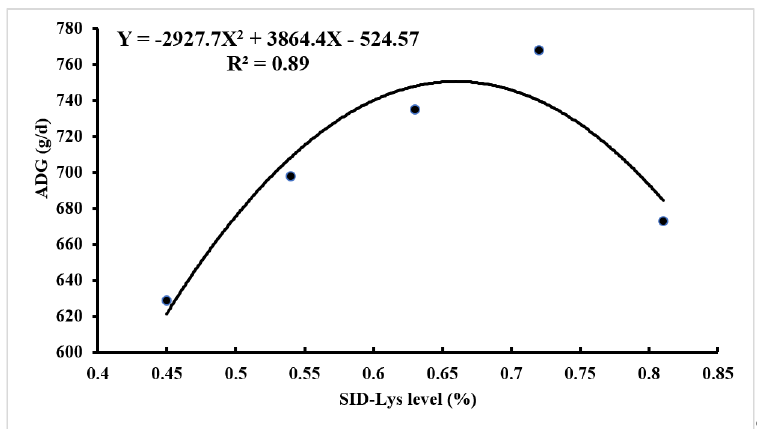
Figure 1. Quadratic regression trends between dietary SID Lys level and F:G of Baqing pigs for 20– 40 kg.